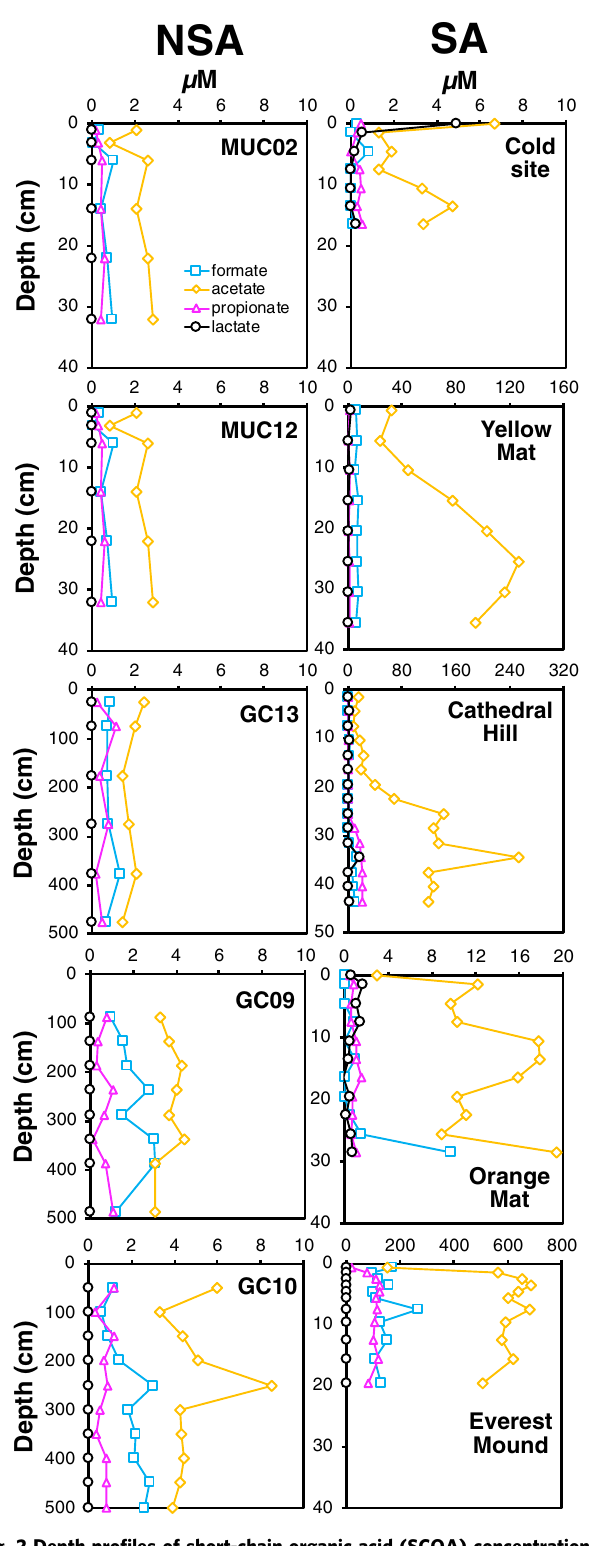
Fig. 2 Depth pro fi les of short-chain organic acid (SCOA) concentrations across locations. Note the differences in concentration ranges on the x -axis and depth ranges on the y -axis (Cathedral Hill: 0 – 50 cm; GC13, GC09, and GC10: 0 – 500 cm; all others: 0 – 40